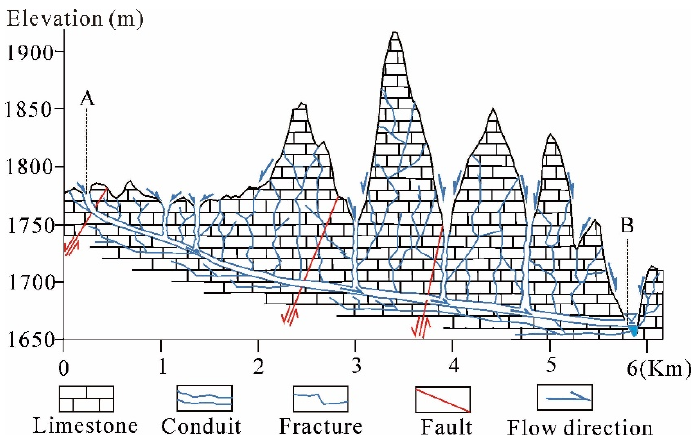
Figure 5. Cross ‐ section schematic diagram of the subterranean river flow